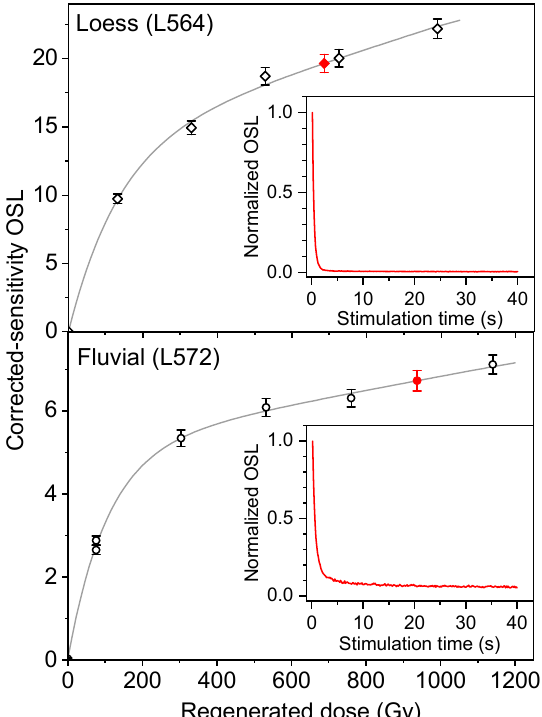
Figure 4. Dose response curves for fine quartz grains from loess sample (L564) and coarse quartz grains from fluvial sand sample (L572). The two curves are fitted by the functions of y = 13.8(1 − exp( − (x + 0.139)/136) + 0.00869x and y = 3.17(1 − exp( − x/83.3)) + 4.4(1 − exp( − x/406)) + 0.0406, respectively. The filled diamonds and circles represent the corrected sensitivity natural signals. The insets show the decay curves for the natural signals from the two quartz samples. Note that the signals were normalized to unity at the first